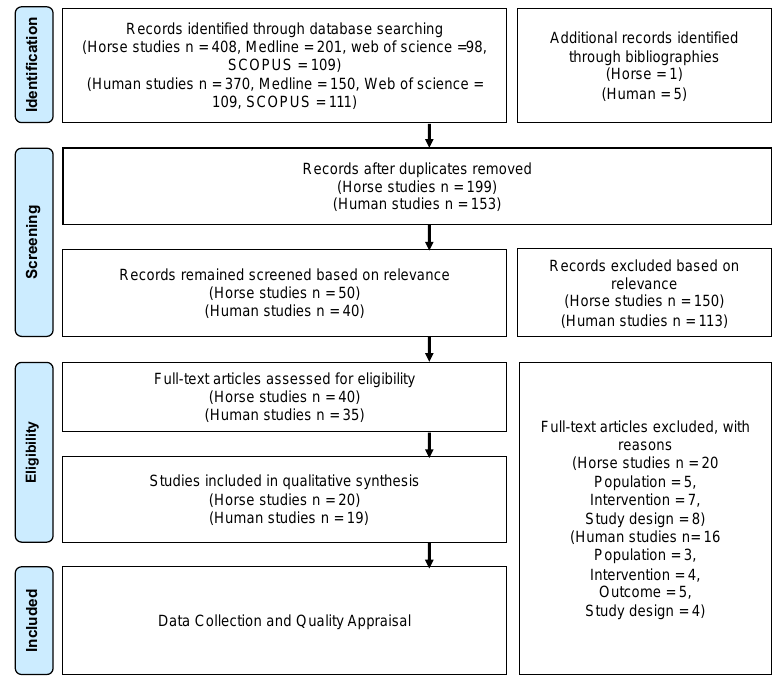
Figure 1. Preferred reporting items for systematic reviews and meta-analyses (PRISMA) 2009 flow diagram for the numbers of studies identified, screened, assessed for eligibility and included in this systematic review.